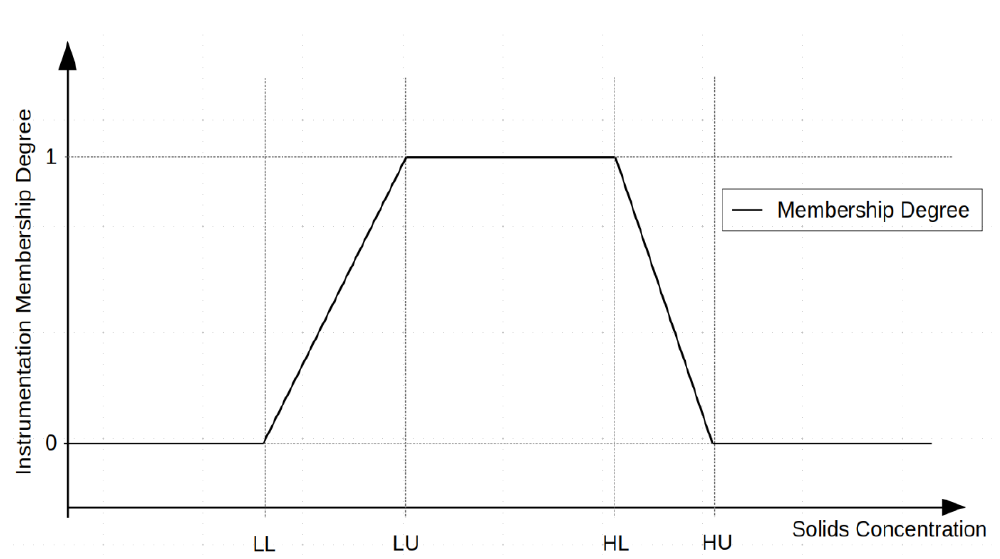
Figure 3. Instrumentation membership degree fuzzy rule.